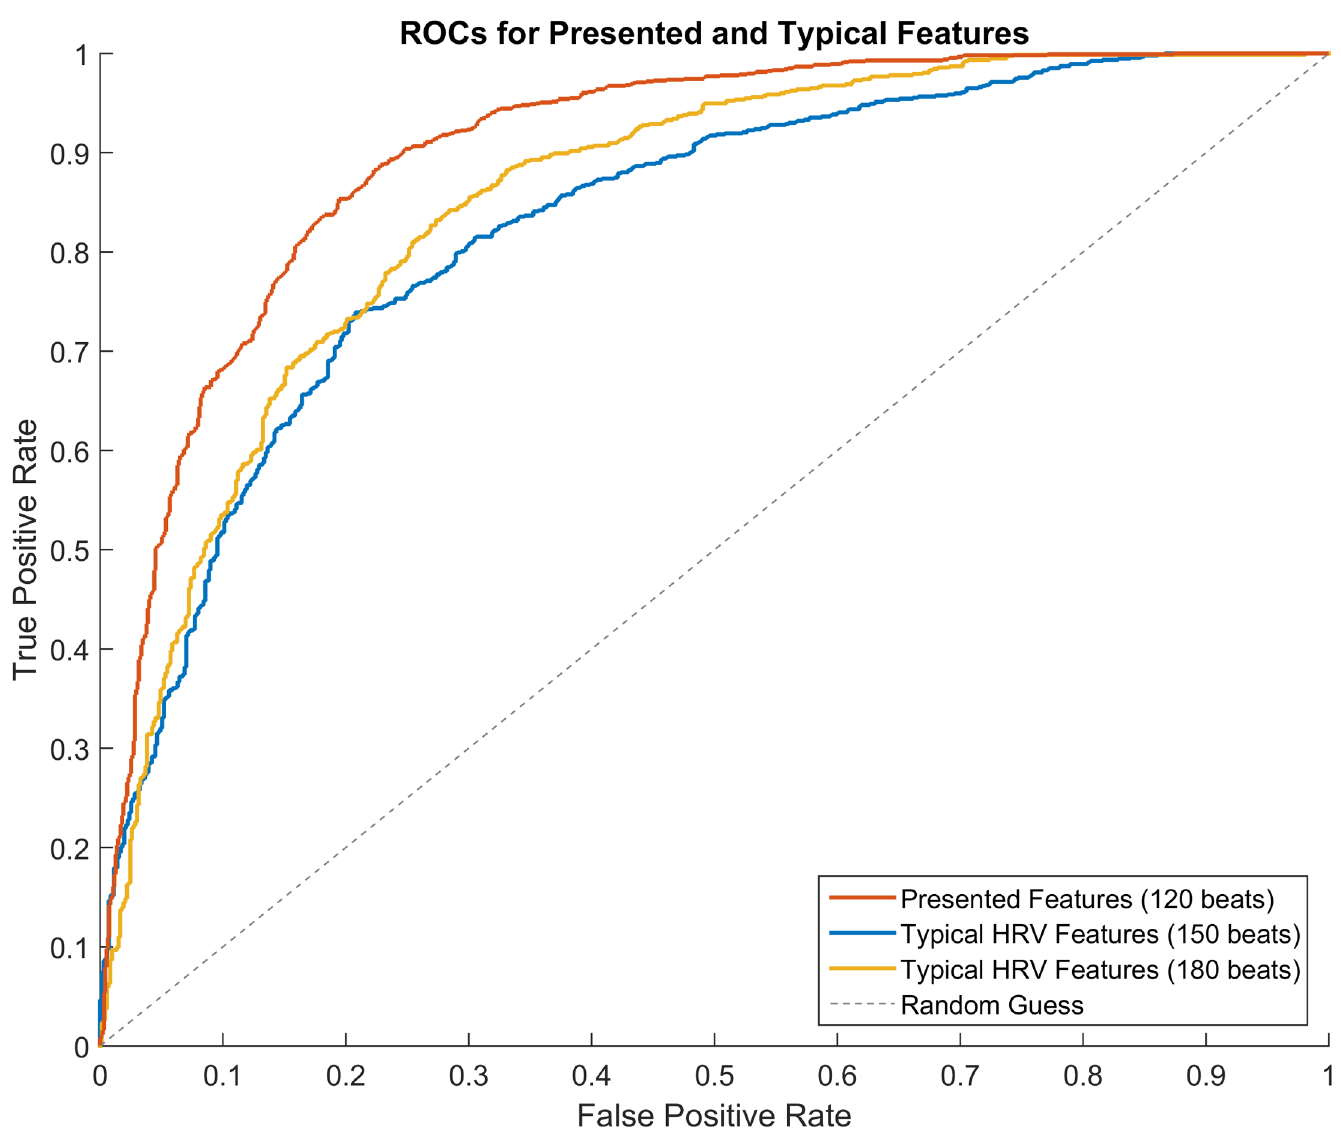
Fig 7. ROC. Receiver operating curves for each feature set ’ s highest-performing window